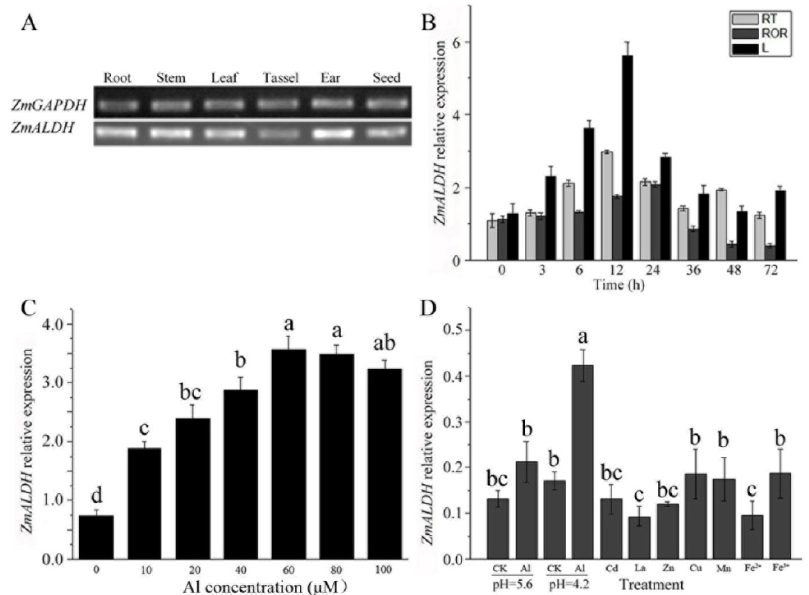
Figure 2. Expression analysis of the ZmALDH gene: ( A ) Spatial expression patterns of ZmALDH in different tissues; ( B ) Transcript levels of ZmALDH in the maize seedlings of root tips (RT), the rest of the root (ROR), and the leaves (L) were quantified at 0, 3 h, 6 h, 12 h, 24 h, 36 h, 48 h, and 72 h after Al treatment (pH 4.2); ( C ) Expression analysis of ZmALDH under different concentrations of Al. Seedlings were treated for 6 h with 0 µ M, 10 µ M, 20 µ M, 40 µ M, 60 µ M, 80 µ M, and 100 µ M Al, and then the roots were collected for RT-PCR; ( D ) Effect of other cations on ZmALDH expression. Seedlings were exposed for 6 h to a 0.5 mM CaCl 2 solution (pH 4.2) containing 30 µ M CdCl 2 , 2.0 µ M CuCl 2 , 10 µ M LaCl 3 , 100 µ M ZnCl 2 , 200 µ M MnSO 4 , 20 µ M FeSO 4 · 7H 2 O, 20 µ M FeCl 3 , or 60 µ M AlCl 3 , respectively. The roots were then collected for subsequent RT-PCR. Relative gene expression normalized to the ZmGAPDH . The values are presented as mean ± SD ( n = 5) and different letters indicate significant difference at p < 0.05 (Tukey’s